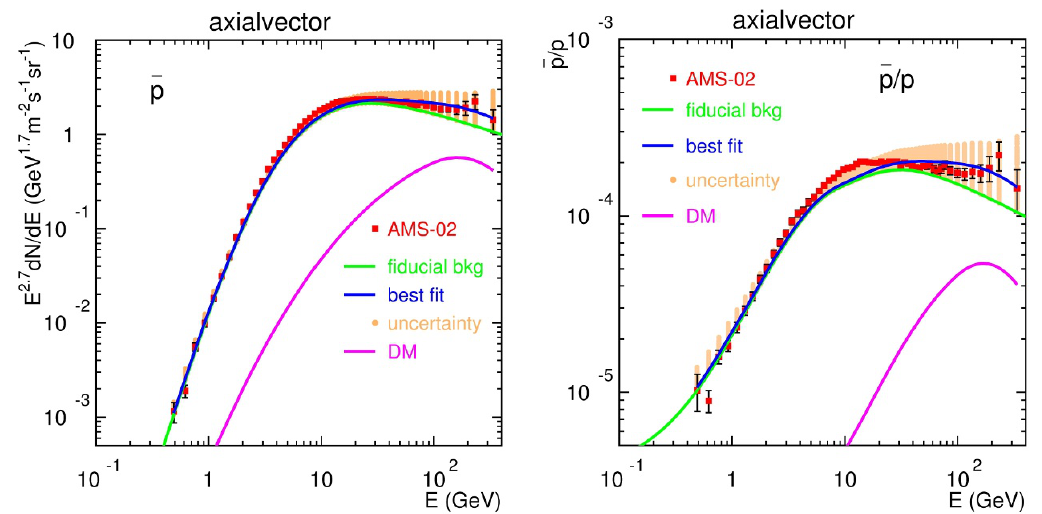
Figure 4 . Antiproton (cid:13)ux (left) and antiproton-to-proton ratio (right) observed by AMS-02 (red dots and dark error bars) in the simpli(cid:12)ed dark matter model with an axialvector